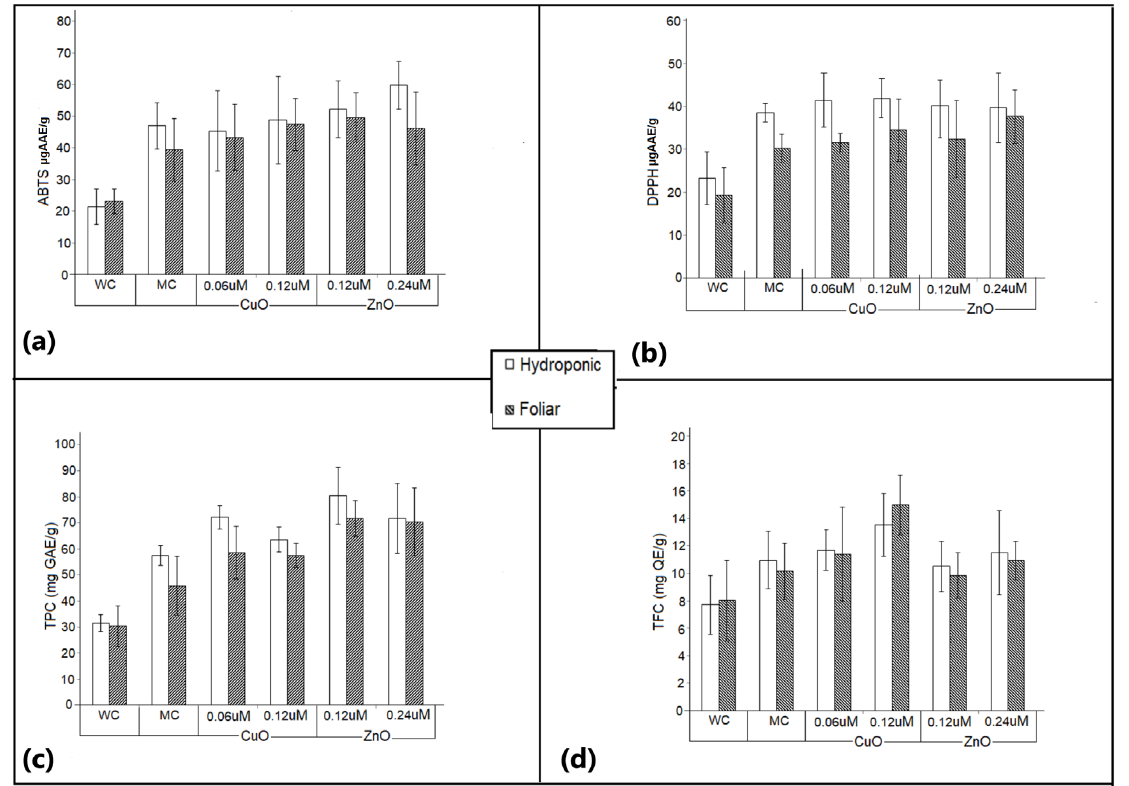
Figure 9. Effect of varying concentrations of biogenic CuO and ZnO nanoparticles applied under hydroponic and foliar setup on antioxidant activity measured by ( a ) ABTS assay, ( b ) DPPH assay, and ( c ) total phenolic content. ( d ) Total flavonoid content in Amaranthus hybridus plant. Significant difference ( p < 0.05). A water control (WC) and media control (MC) were maintained.